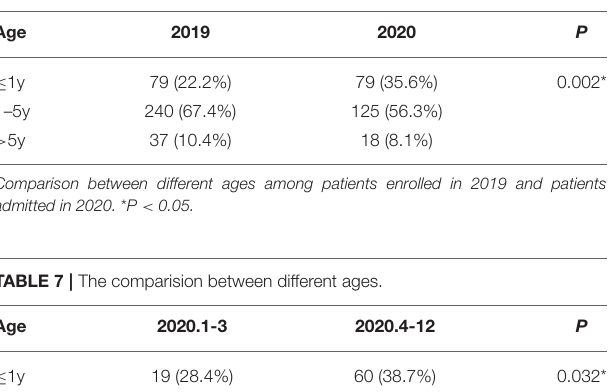
TABLE 6 | The comparision between different ages.